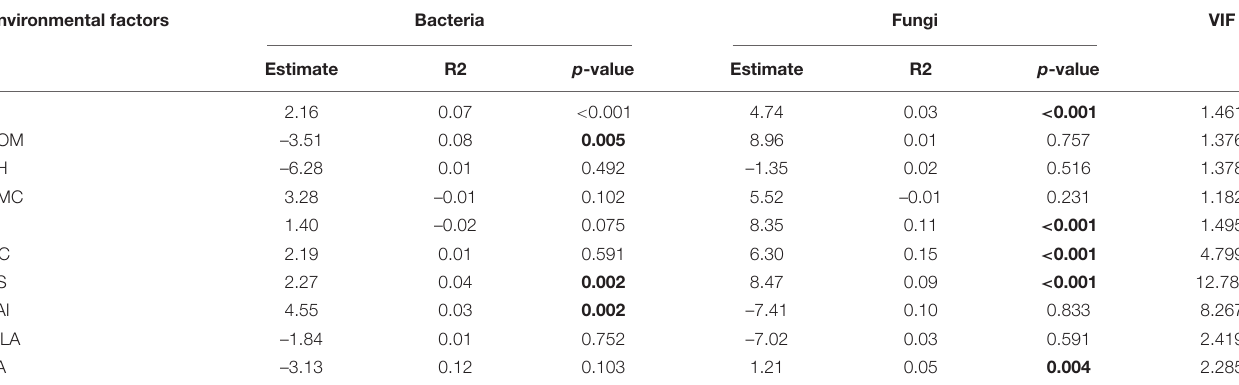
Environmental factors Bacteria Fungi